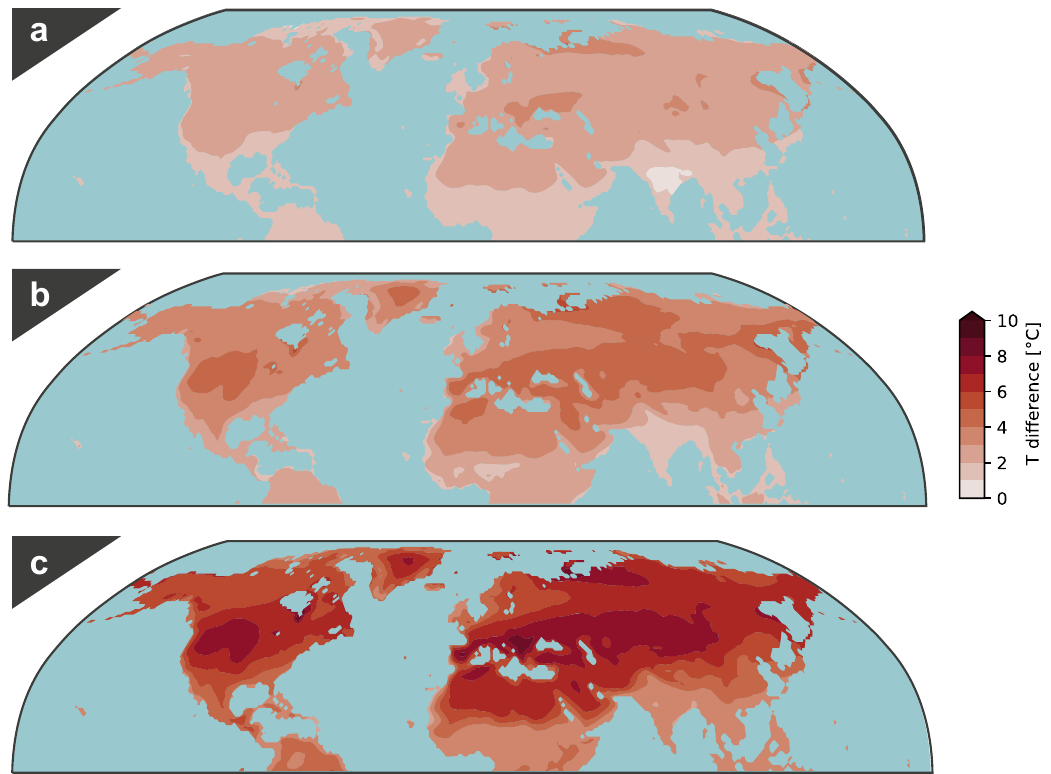
Fig. 3 Projected changes to the Northern Hemisphere summer temperature. a – c Spatial distribution of the summer temperature anomalies in the Northern Hemisphere based on the multi-model projected changes (2071 – 2100) based on SSP1-2.6 ( a ), SSP2-4.5 ( b ) and SSP5-8.5 ( c ) scenarios relative to the historical summer temperature during the 1971 – 2000 baseline period. All changes are signi fi cant according to the two-sided Student ’ s t test ( p <